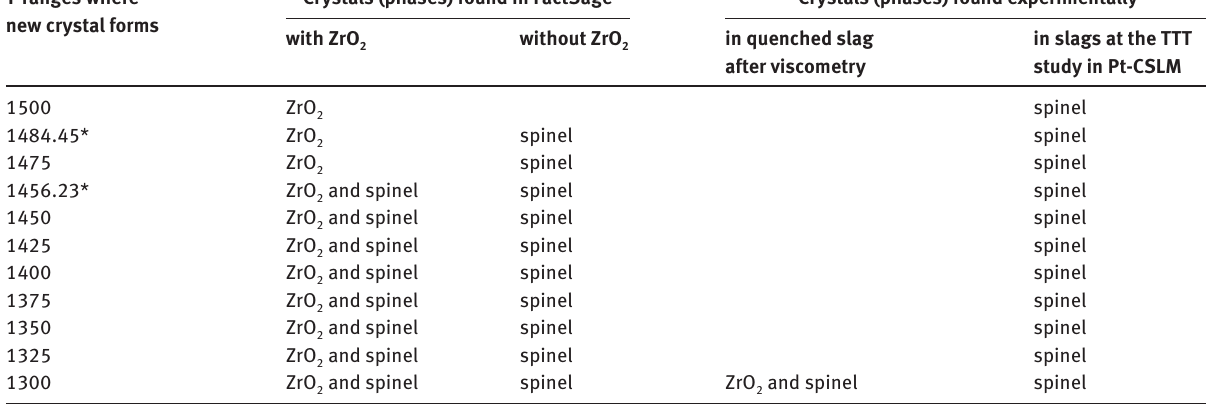
Table 4: Solid phases thermodynamically predicted by Factsage and found experimentally in the western coal